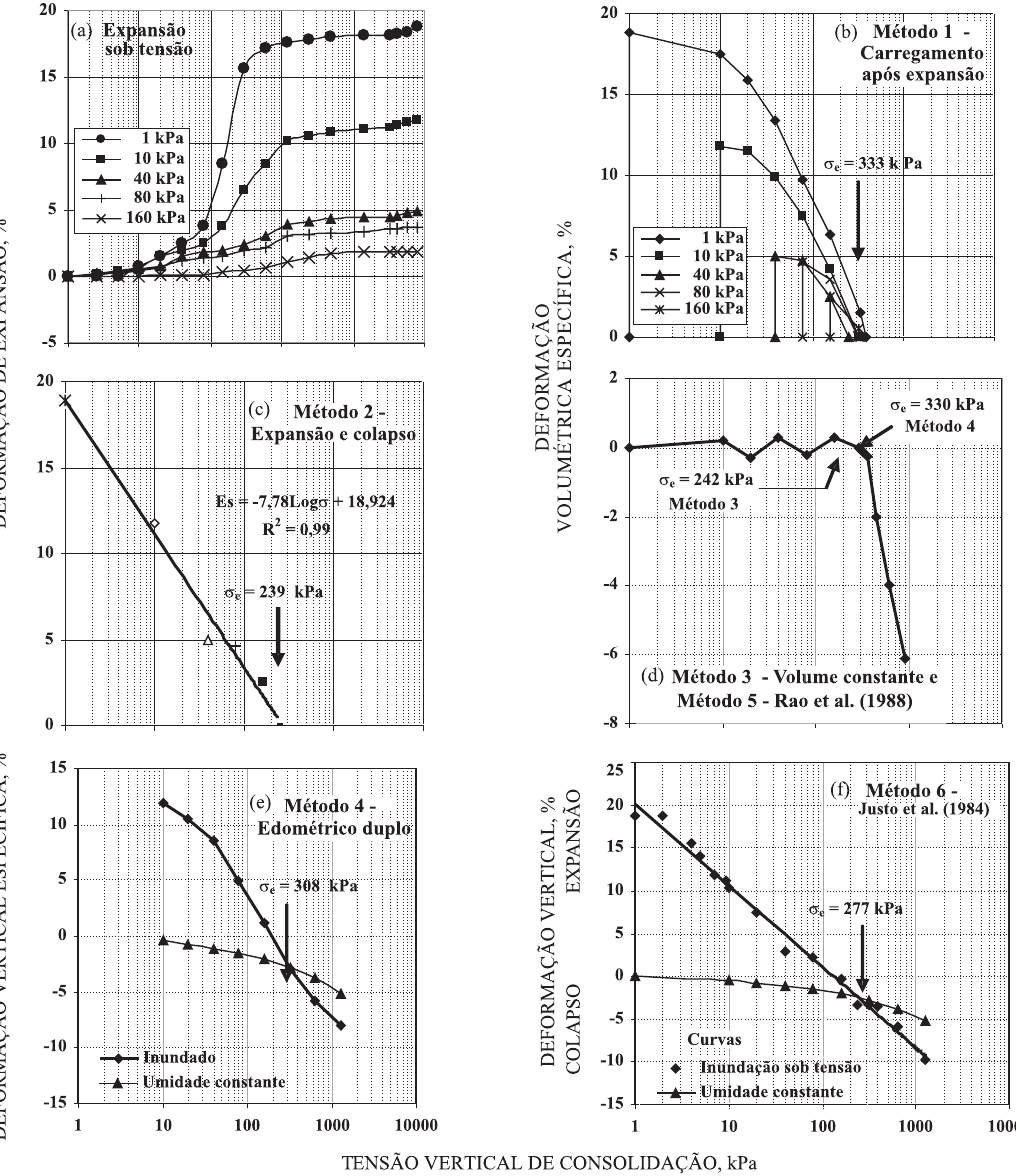
Figura 8. Métodos de tensão de expansão: (a) expansão sob tensão; (b) carregamento após expansão; (c) expansão e colapso; (d) volume constante e Rao et al. (1988); (e) edométrico duplo; (f) Justo et al. (1984). H: horizonte; T: tangente à curva; B: bissetriz do ângulo formado entre a horizontal e a tangente; σσσσσ tensão de expansão; r 2 : coeficiente de